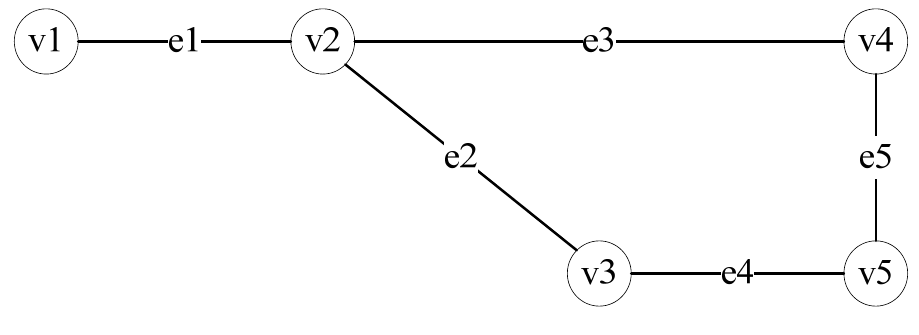
Figure 7. Number of graph G.